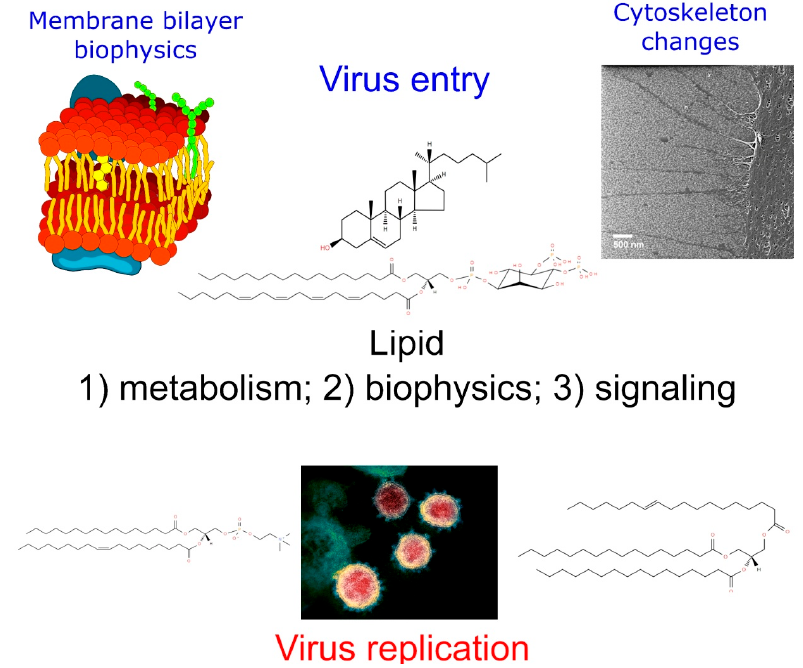
Figure 3. Comprehensive view of the virus replication process and the main lipids involved in every step.